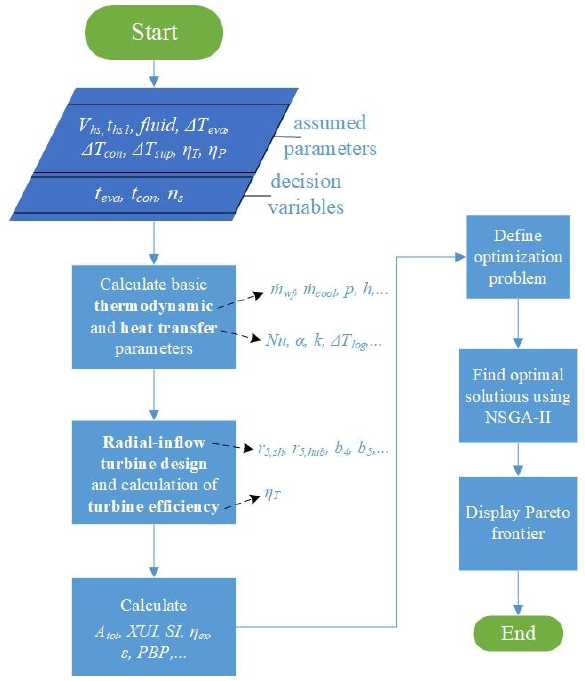
Figure 2. Flowchart of calculation procedure.